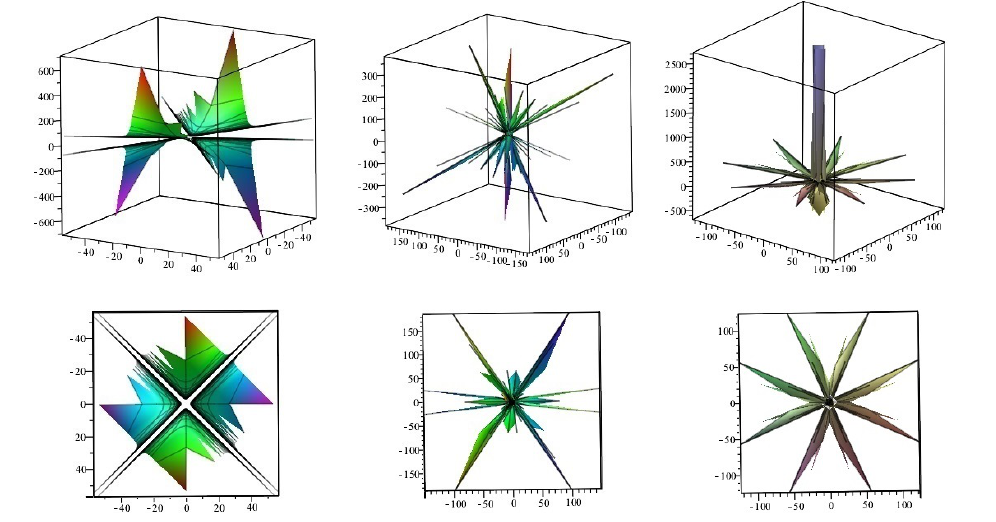
Figure 5. Enneper maximal surfaces in inhomogeneous tangential coordinates ( Left ): (cid:98) E 1 ( u , v ) , ( Middle ): (cid:98) E 2 ( u , v ) , ( Right ): (cid:98) E 3 ( u , v )